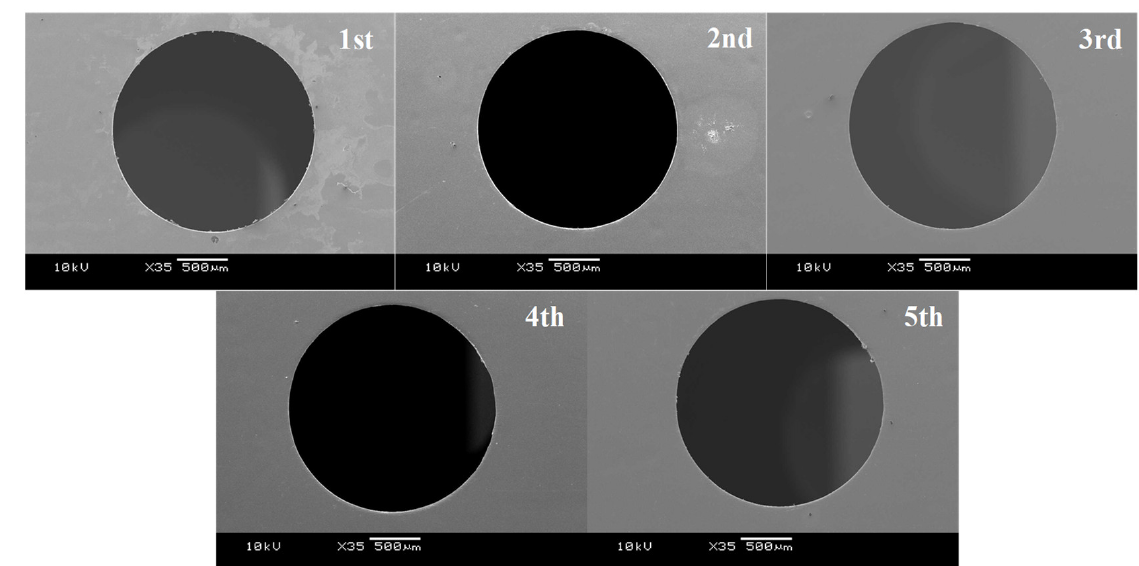
Figure 3. SEM image on the punch head and side surfaces of normally ground WC (Co) punch across the punch edge with various magnification. ( a ) Overall view of the trimmed, diamond-coated punch, ( b ) Higher magnification image on the punch edge, and ( c ) Highest magnification image on the vicinity of the edge.